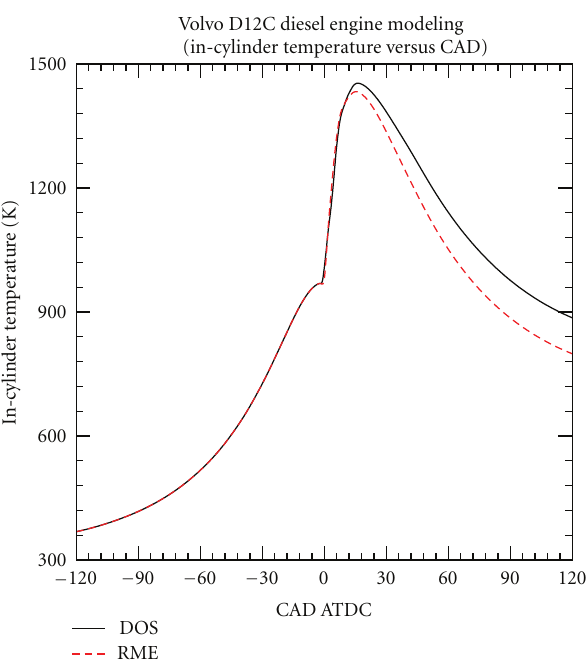
Figure 7: Averaged in-cylinder temperatures for the Volvo D12C diesel engine fuelled by DOS (solid line) and RME (dash line), without